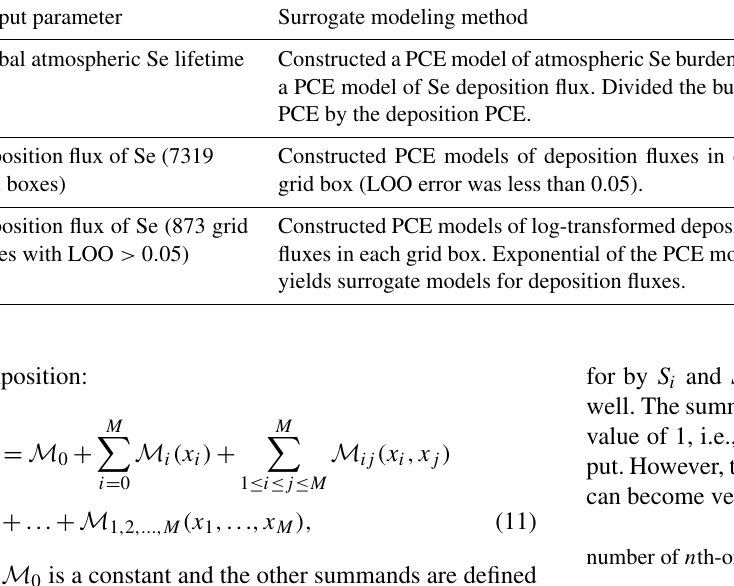
Table 4. Summary of methods to construct surrogate models and calculate Sobol’ sensitivity indices of the SOCOL-AER output parameters. Output parameter Surrogate modeling